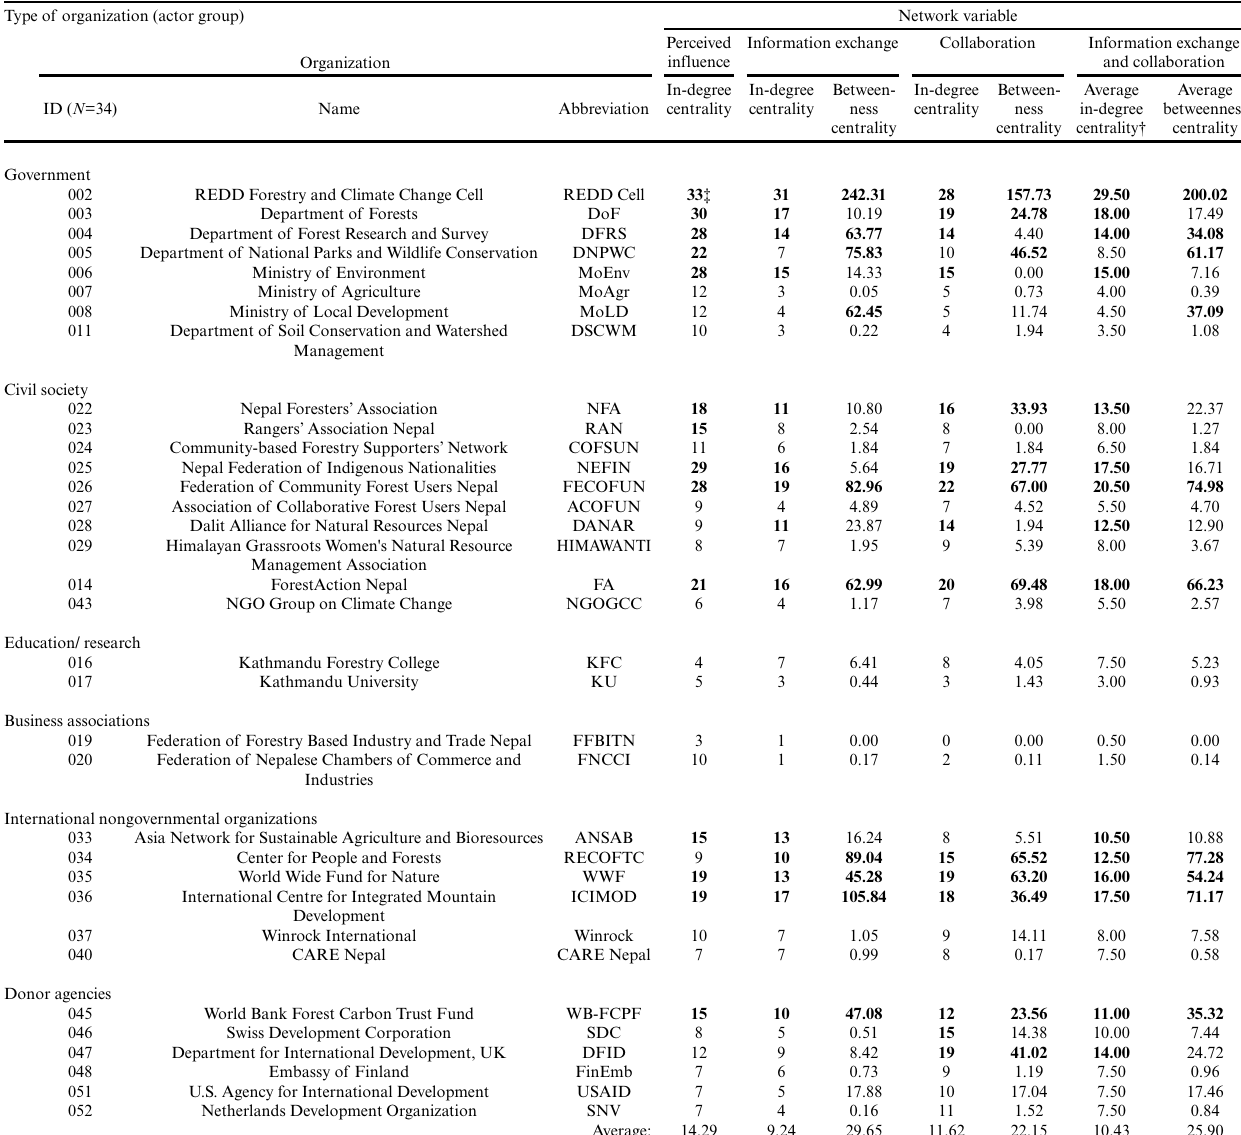
Table 2. Perceived influence, information exchange, and collaboration of individual actors. Type of organization (actor